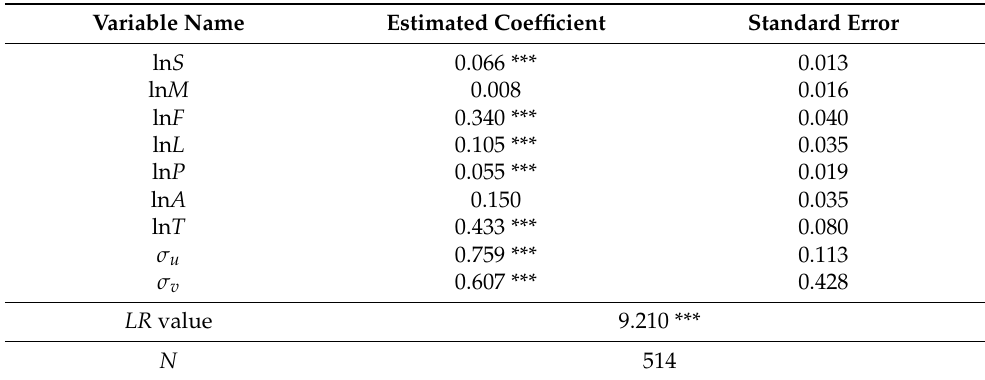
Table 3. Estimates of parameters of the stochastic frontier production function. Variable